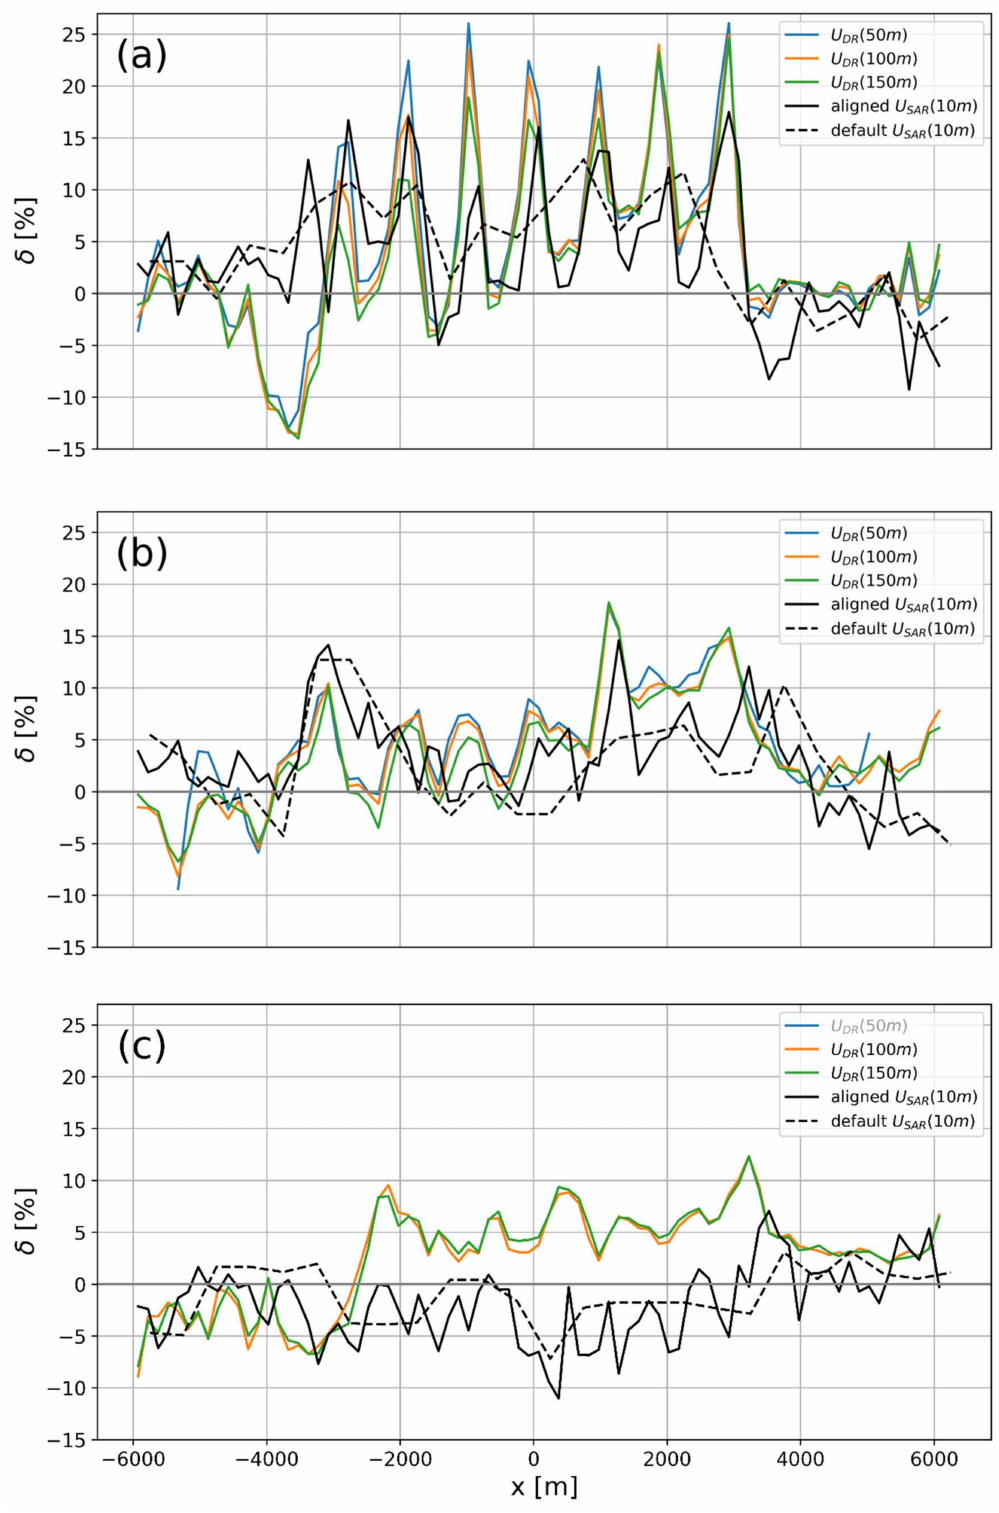
Figure 7. Transects for Case 1 at ( a ) 700 m, ( b ) 3700, and ( c ) 7700 m distance downstream. Three Doppler radar heights, 50, 100 and 150 m are shown, and SAR wind speeds retrieved at the transect with aligned and default processing. x is the cross-wind distance from turbine F04 (middle of the last